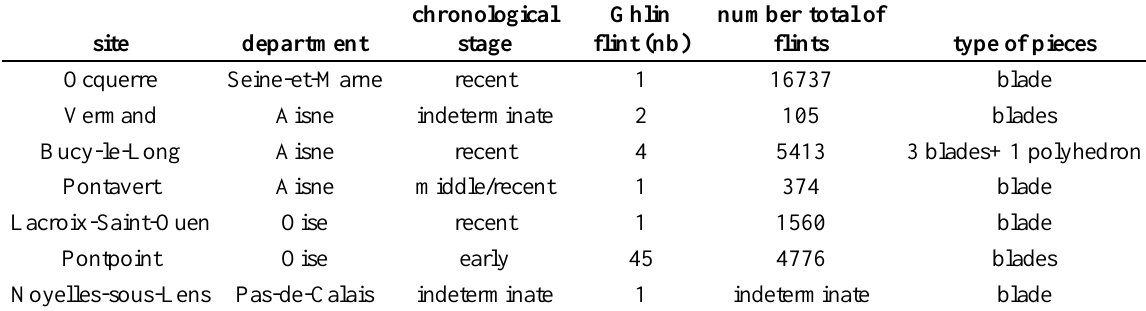
Table 1- Table that described the data of all the VSG sites which provided Ghlin flint.